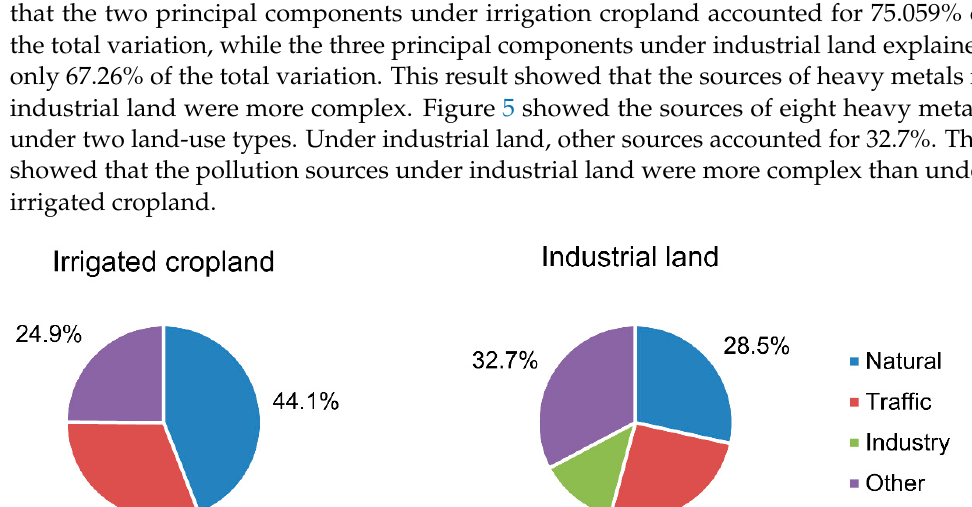
Table 7. Principle component analysis of heavy metals in irrigation cropland soil.